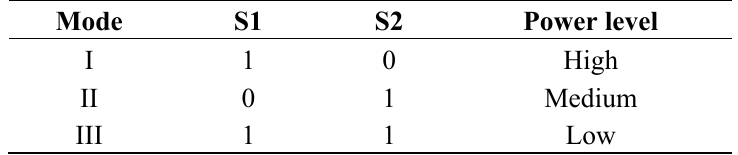
Table 1. States of S1 and S2 and the power level of each operating